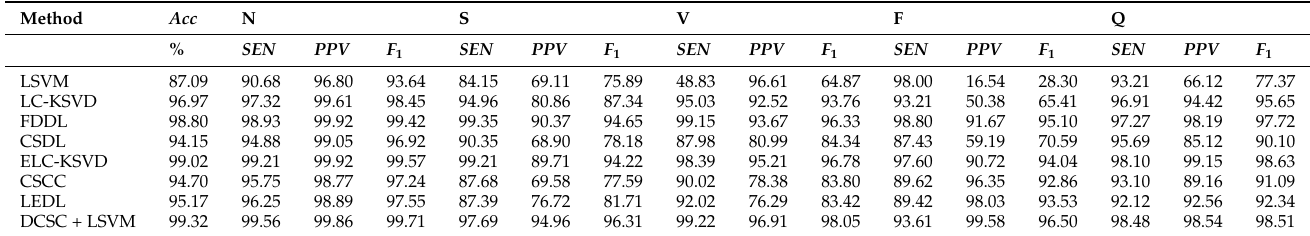
Table 3. Performance metrics of different algorithms.